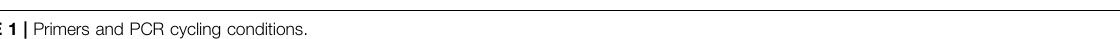
TABLE 1 | Primers and PCR cycling